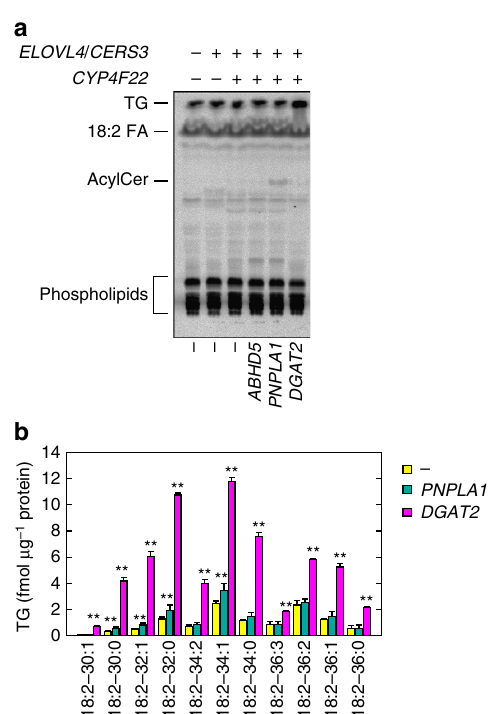
Figure 3 | Overexpression of DGAT2 but not PNPLA1 causes an increase in TG levels. ( a ) HEK 293T cells transfected with plasmids encoding the indicated genes were labelled with [ 14 C]linoleic acid for 4h at 37 (cid:2) C. Lipids were extracted, separated by normal-phase TLC and detected by autoradiography. 18:2 FA, linoleic acid; AcylCer, acylceramide. Four independent experiments gave similar results, and a representative result is shown. ( b ) HEK 293T cells were transfected with an empty vector or the plasmid encoding 3xFLAG-PNPLA1 or 3xFLAG-DGAT2 . Twenty-four hours after transfection, lipids were extracted and subjected to LC-MS/MS analysis. TGs containing linoleic acid were detected by MRM mode and quantified using MassLynx software. The graph depicts the amount of each TG species containing linoleic acid (18:2) and FAs with the indicated chain- length and degree of unsaturation. For example, 30:1 means that the sum of chain-length and degree of unsaturation of the two FA chains other than linoleic acid are 30 and 1, respectively. Values represent the means ± s.d.s of six (for control) or three (for PNPLA1 and DGAT2 ) independent experiments. Statistically significant differences compared to control cells are indicated (two-tailed Student’s t -test; ** P o 0.01).